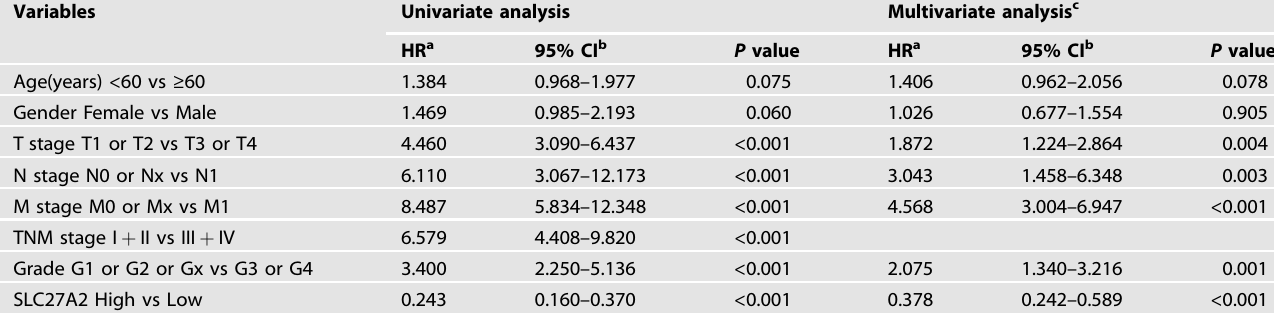
Table 2. Univariate and multivariate analyses of risk score and patient disease free